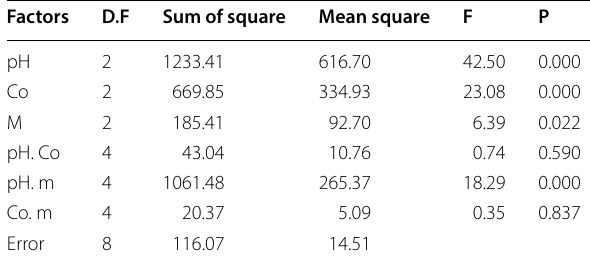
Table 3 ANOVA results of bisacodyl removal efficiency